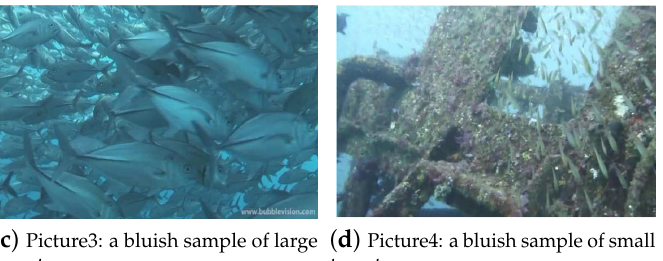
Figure 2. Underwater test pictures.